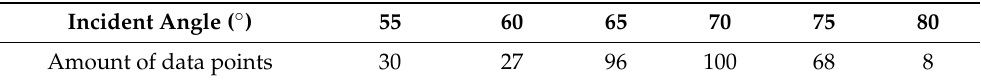
Table 2. Amounts of data points in an accurate region shown in Figure 5 in the 100 repeated measurements for different incident angles at a wavelength of 350 nm.